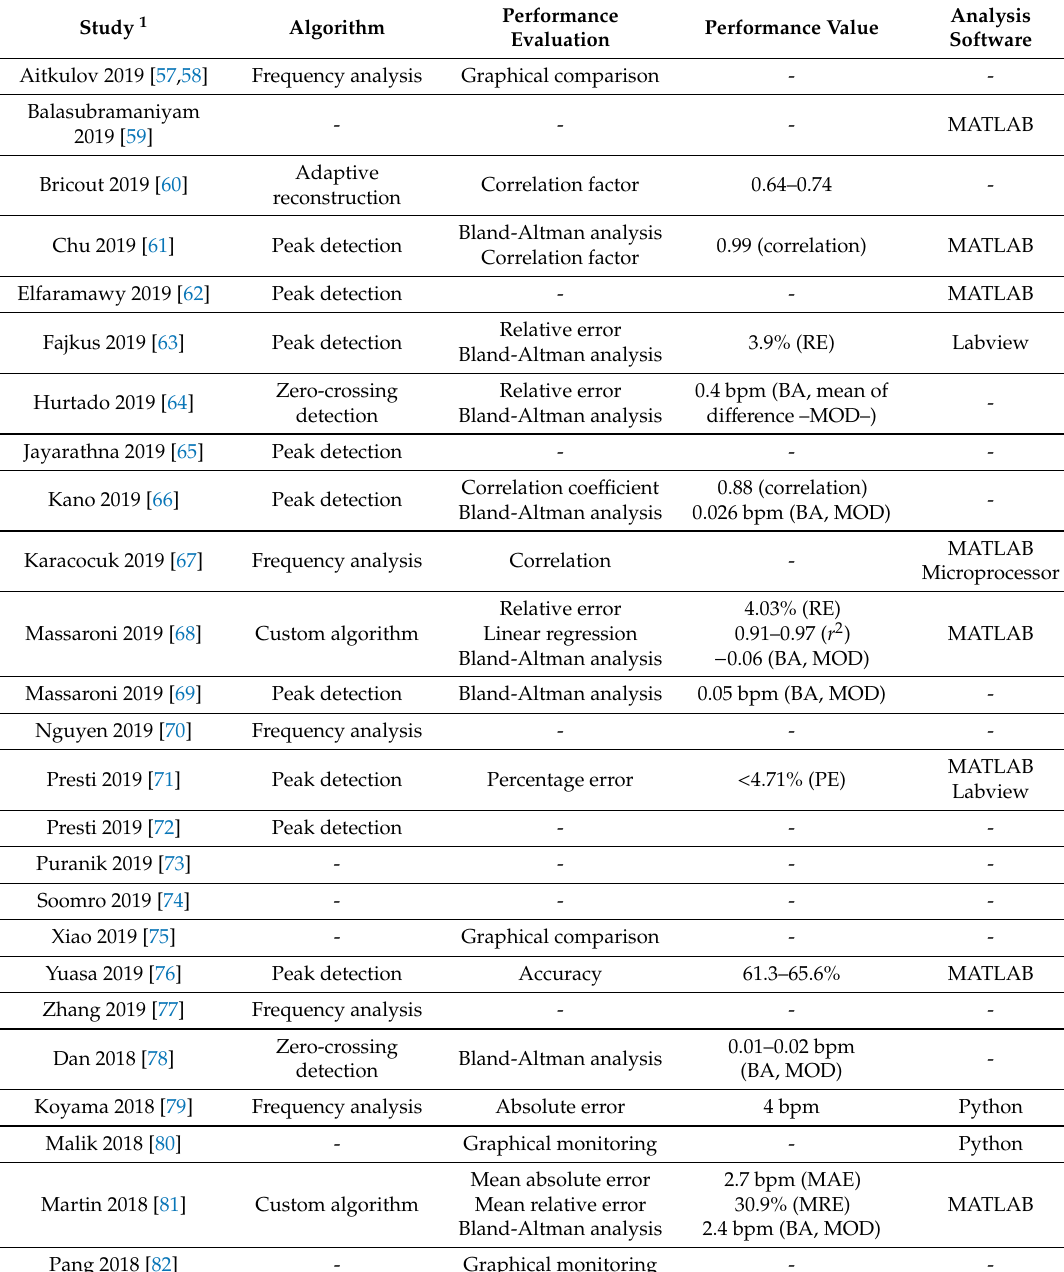
Table 6. Analysis of the processing algorithm, performance evaluation, and software for the studies of the wearable